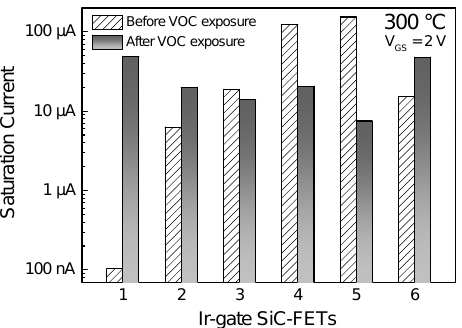
Figure 3. Saturation currents measured on six Ir-gate SiC-FETs at 300 ◦ C and 2V applied gate bias, V GS , before and after exposure to VOCs.